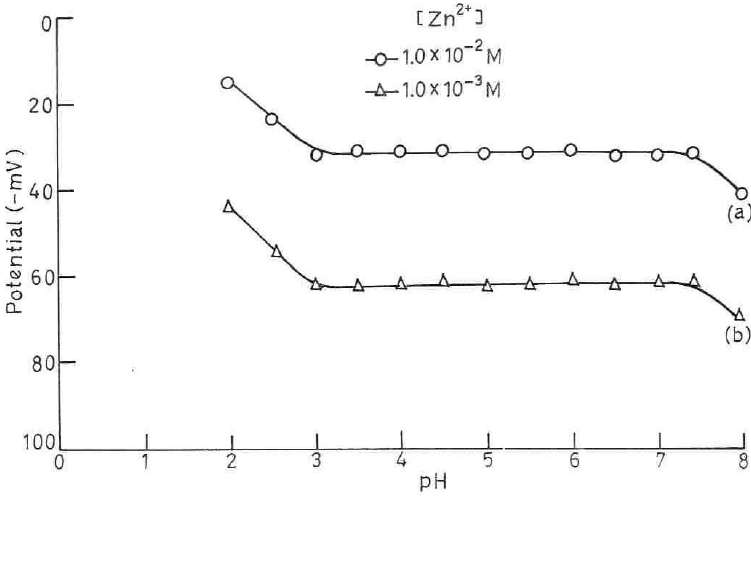
Figure 3 : Effect of pH on potential; [Zn 2+ ]= 1.0 · 10 -2 M (a) and 1.0 · 10 -3 M (b) for sensor no.2.